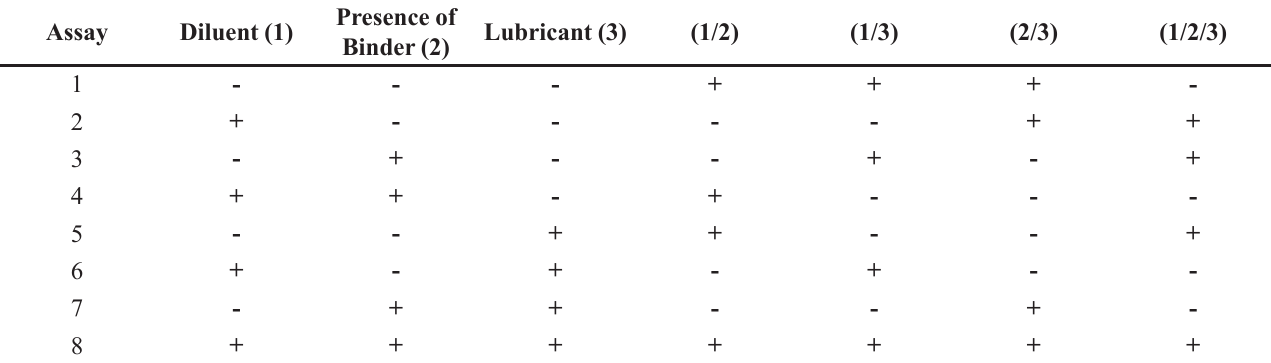
TABLE I - Factorial planning matrix 2 3 for optimization of Lippia origanoides H. B. K. tablets. Diluent (cellulose-; babassu+); Use of PVP 1% as a binder (no -, yes +), Lubricant (0,5% -; 1,0% +). Interaction of parameters 1 e 2 (1/2); Interaction of parameters 1 e 3(1/3); Interaction of parameters 2 e 3 (2/3); e Interaction of parameters 1, 2 e 3 (1/2/3)